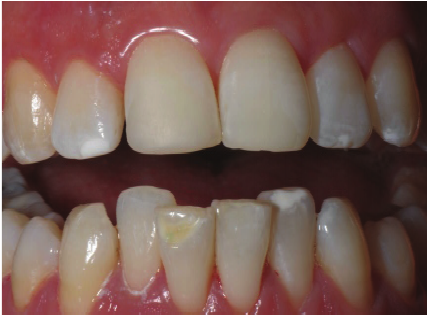
Figure 6: Grade II specific enamel defects in a potential coeliac patient (B Group). Symmetrical and chronological position on the following dental elements: 12-13-22-23-32-41.